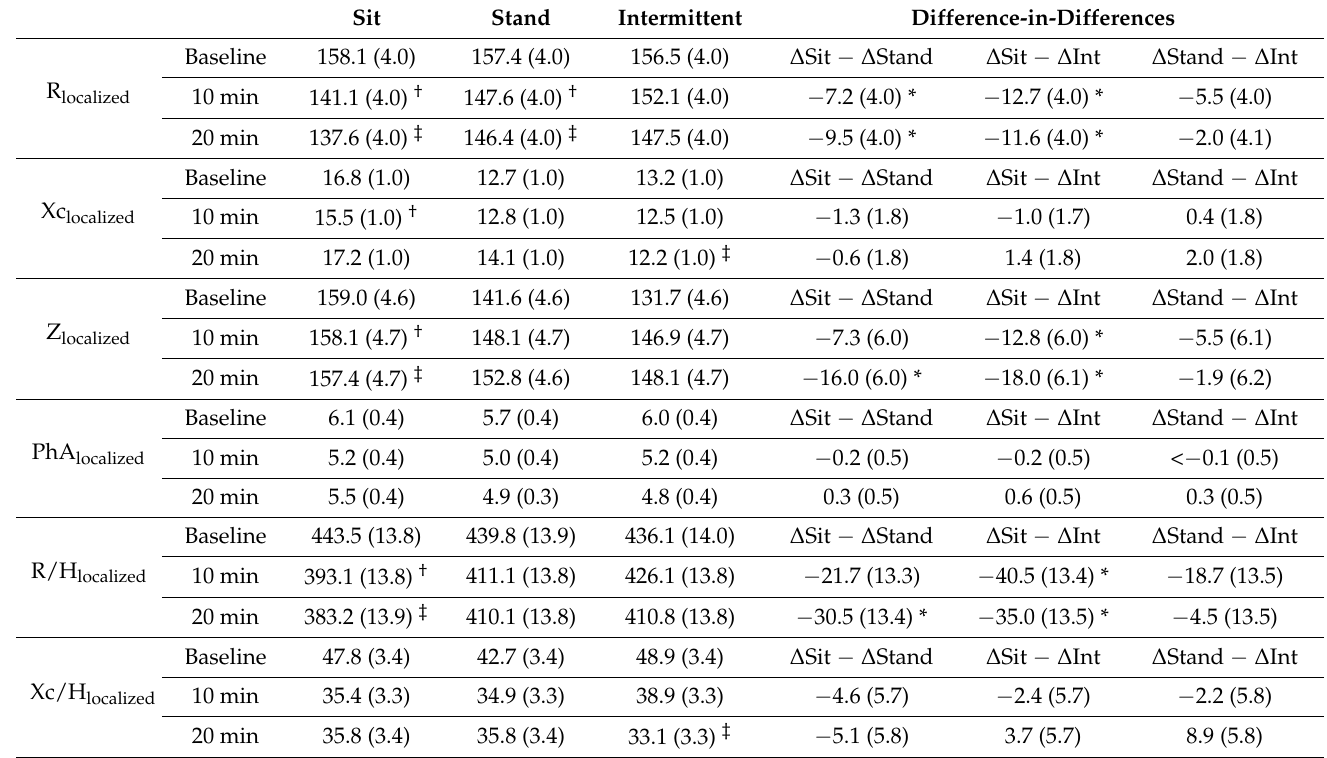
Table 2. Values for localized BIA parameters for sit, stand and intermittent conditions and difference- in-differences among conditions (linear mixed models, adjusted for the condition’s order and sex).